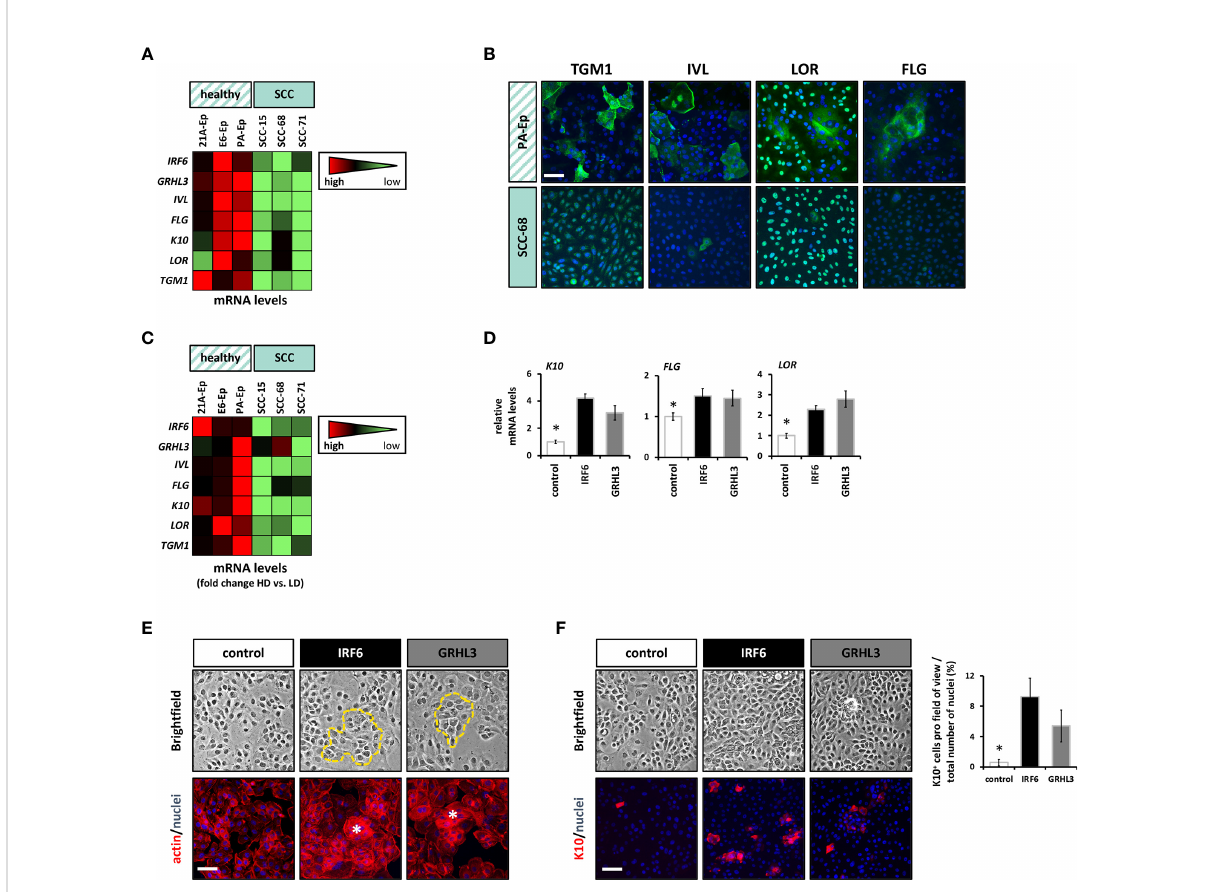
FIGURE 4 Overexpression of IRF6 and GRHL3 induces differentiation. (A) The differentiation status of three normal cell strains compared to three SCC lines was assessed by qPCR for a panel of differentiation markers ( IRF6 , GRHL3 , IVL , FLG , K10 , LOR , and TGM1 ). The data are shown as a heatmap. Scale: light green – low gene expression; red – high gene expression. (B) IF staining for TGM1, IVL, LOR, and FLG in PA-Ep (non-cancerous) vs. SCC-68 indicates less differentiated cells in the SCC-68 cultures. Scale bar: 50 µm. Note that staining for LOR and TGM1 resulted in a nuclear background staining (Supplementary Figure 5). (C) The same healthy cell strains and SCC cell lines were analyzed in low density (LD) and their corresponding high density (HD) cultures, and the same set of differentiation genes was analyzed by qPCR. The results are shown as heatmap of the fold inductions (HD vs. LD). Scale: light green – low gene induction; red – high gene induction. (D) The effect offorced expression of IRF6 (black) and GRHL3 (gray) compared to control SCC-68 (white) on differentiation markers ( K10 , FLG , and LOR ) was determined by qPCR. * p < 0.05 control vs. IRF6 and GRHL3. (E) Bright fi eld pictures and corresponding pictures with actin staining indicate the presence of differentiating cell groups (dashed yellow line in the bright fi eld images and asterisks in the actin staining) in SCC68 cells transduced with IRF6 or GRHL3. Scale bar: 50 µm. (F) K10 staining in dense cultures of transduced SCC-68 cells (left) and its quanti fi cation (right). Note the presence of signi fi cantly more K10-positive cells in SCC-68/IRF6 and SCC-68/GRHL3 compared to SCC-68 control. Scale bar: 50 µm. * p < 0.05 control vs. IRF6 and